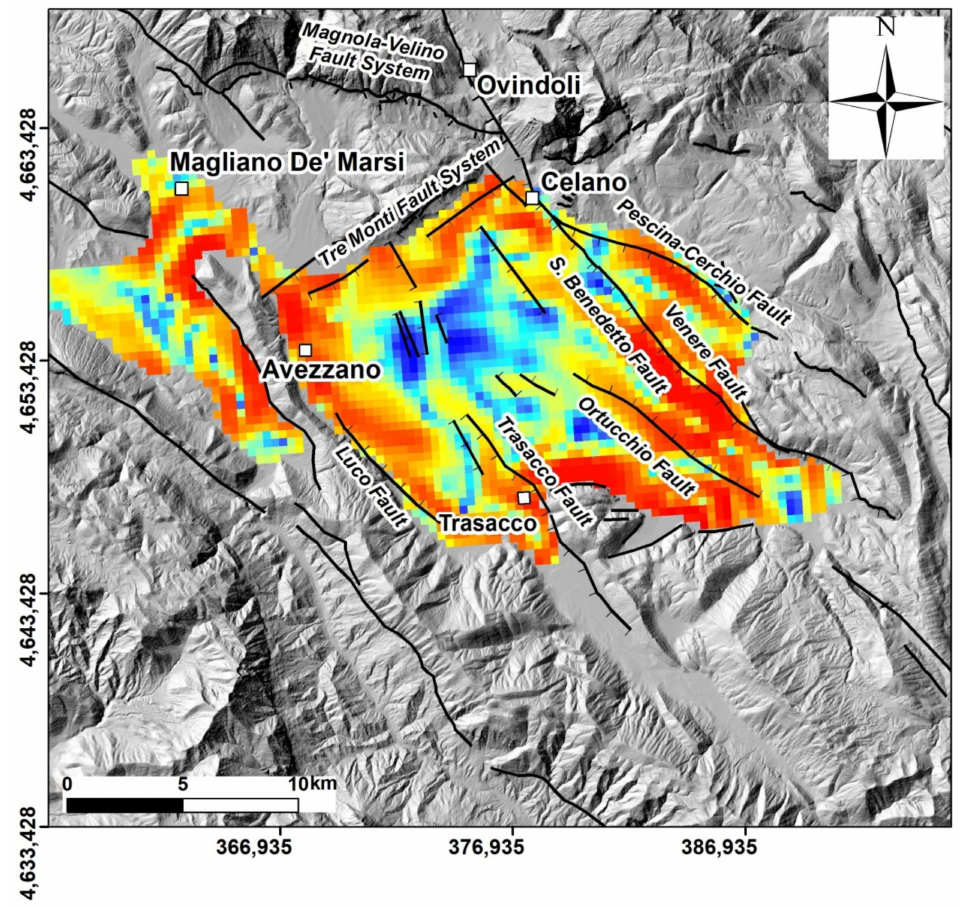
Figure 3. Enhanced horizontal derivative map of the residual gravity field of Figure 2. The maxima (hotter colors) of the signal, expressed in normalized units, show to the position of density contrasts (likely faults). Known faults (black solid lines) from [2]. The Venere Fault was inferred in this paper by EHD analysis (see Section